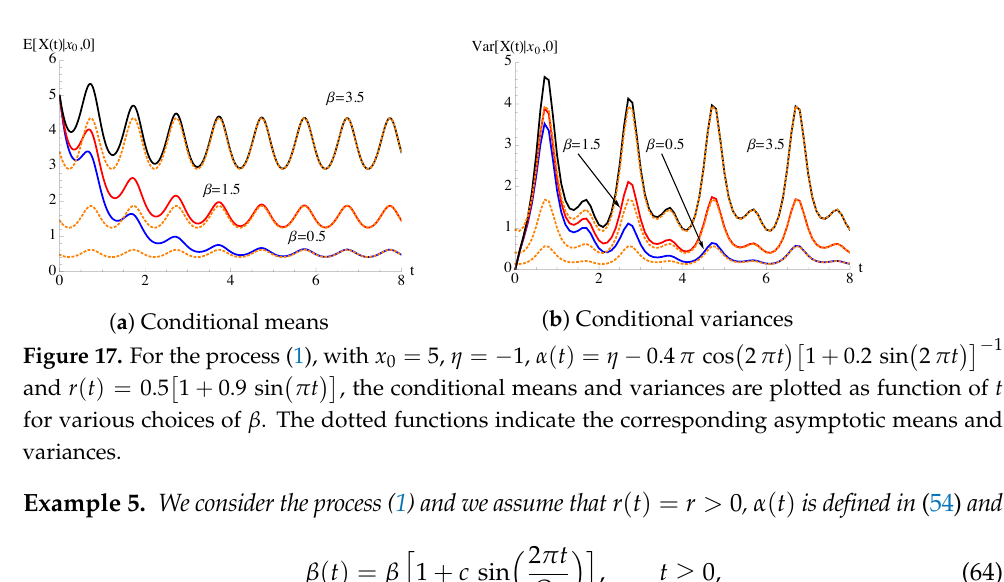
Figure 17. For the process (1), with x 0 = 5, η = − 1, α ( t ) = η − 0.4 π cos (cid:2) (cid:0) (cid:1)(cid:3) π t and r ( t ) = 0.5 1 + 0.9 sin , the conditional means and variances are plotted as function of t for various choices of β . The dotted functions indicate the corresponding asymptotic means and variances.